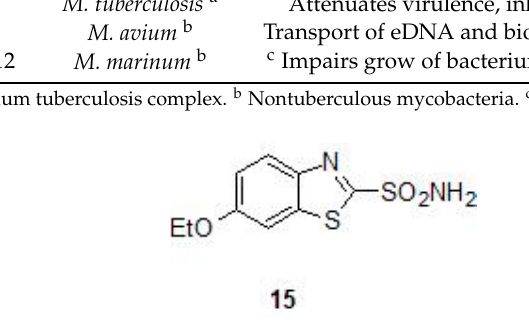
Figure 9. Chemical structure of ethoxzolamide ( 15 ). Table 3. Studies on minimal inhibitory concentrations (MICs) of the CA inhibitors in mycobacterial cultures.